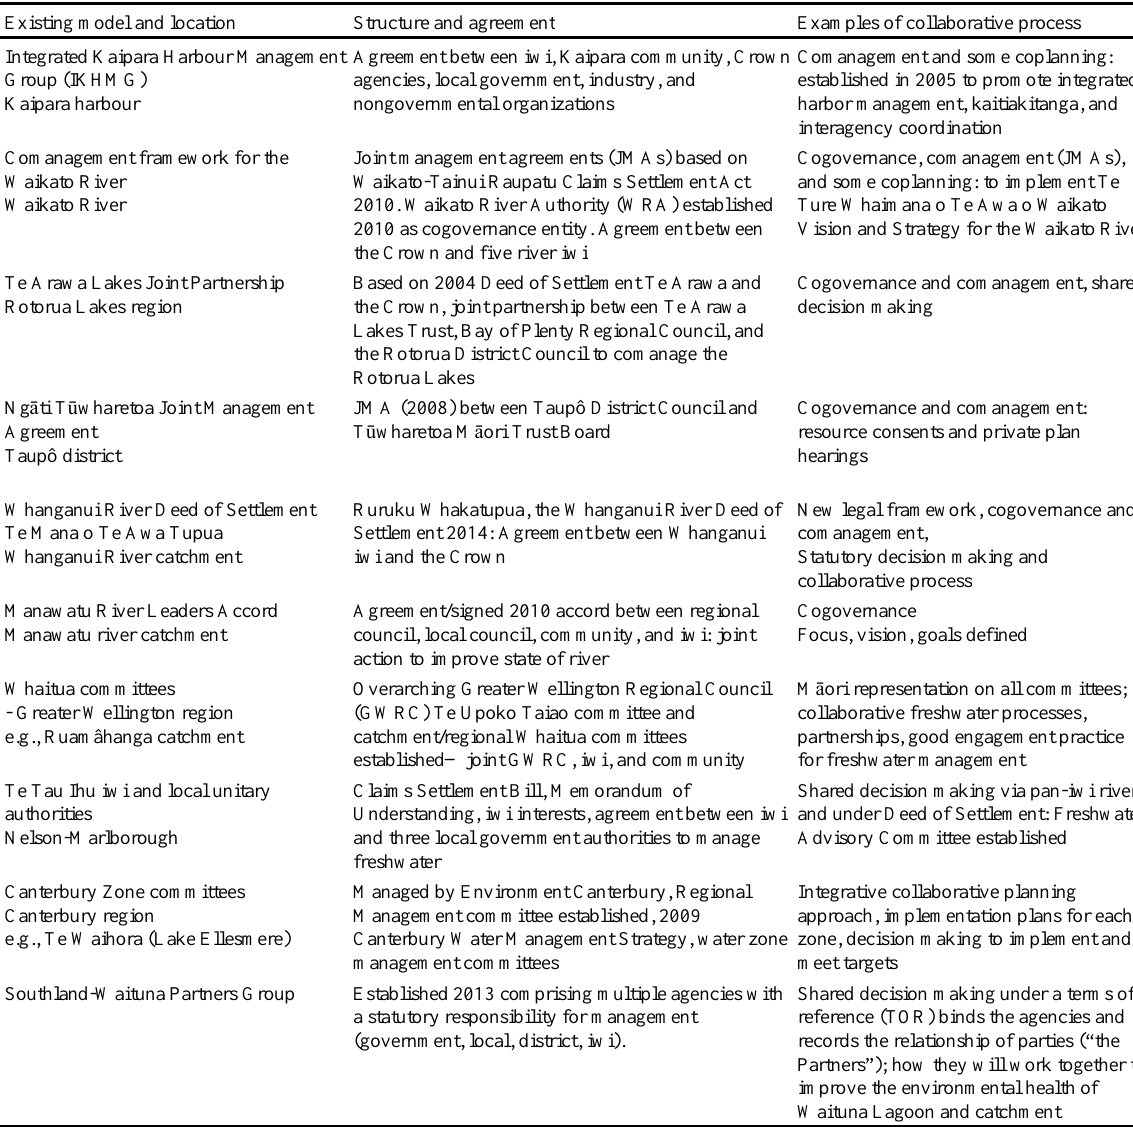
Table 3. Indigenous M ā ori involvement in collaborative processes and freshwater management in New Zealand. Existing model and location Structure and